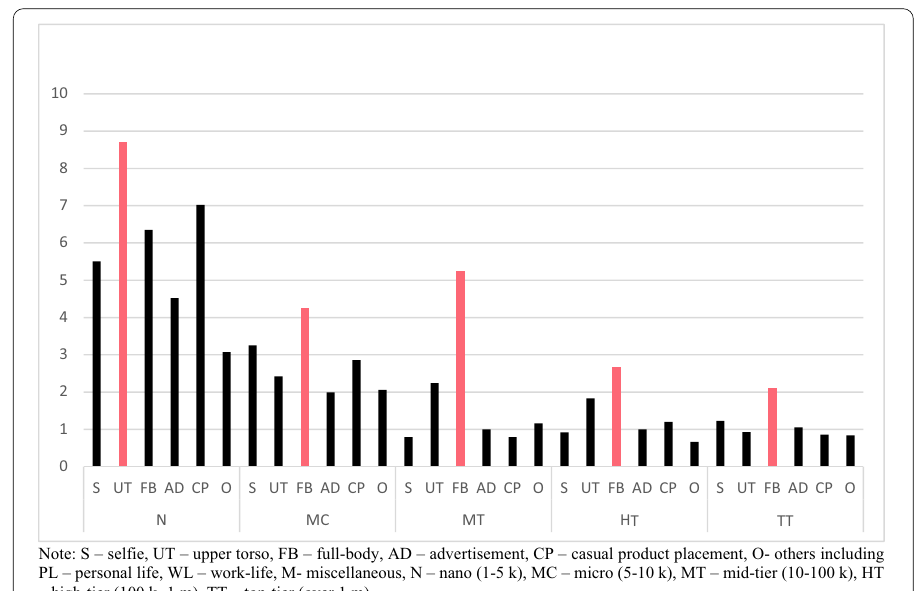
Fig. 1 Engagement rate by image type in